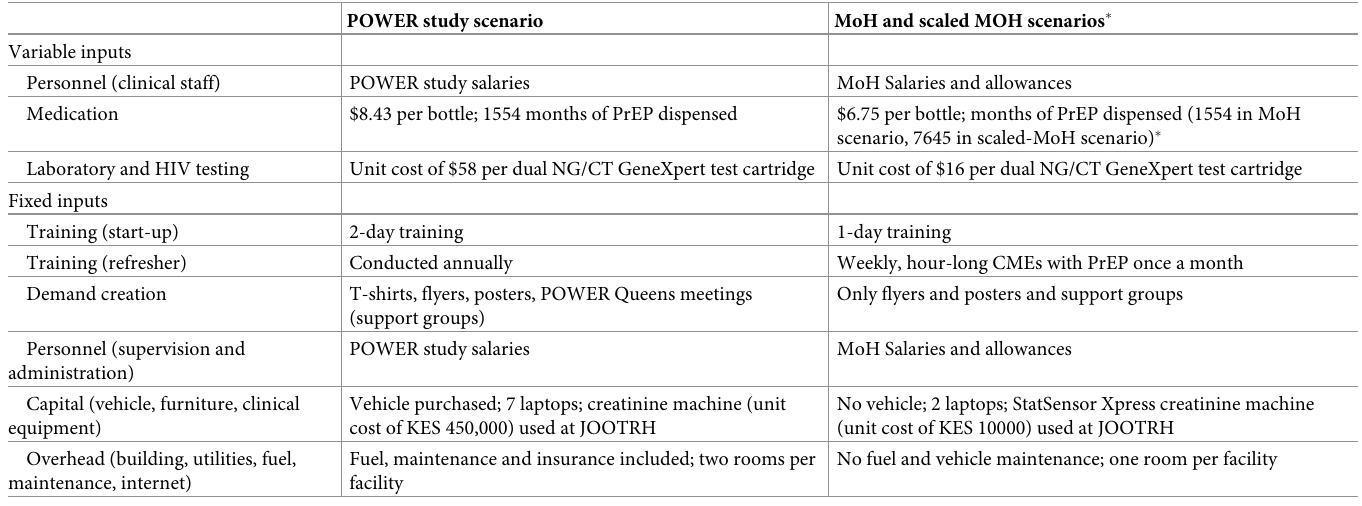
Table 1. Differences inputs per